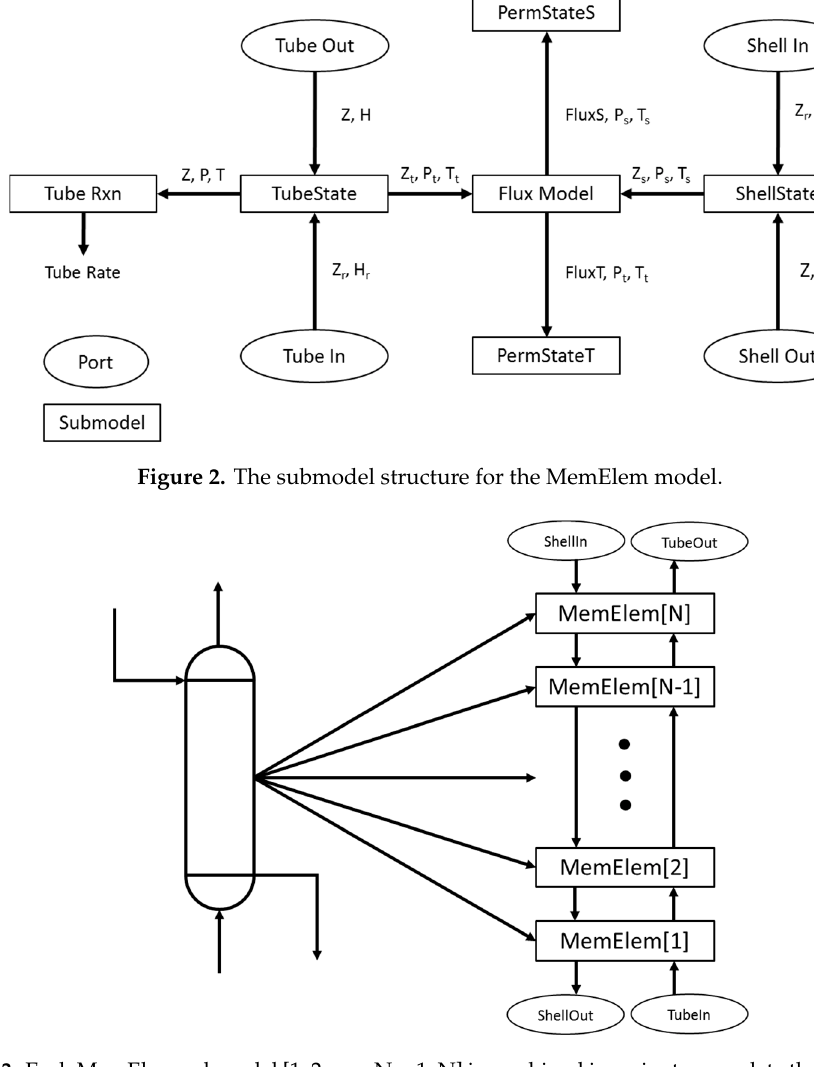
Figure 3. Each MemElem submodel [1, 2, …, N − 1, N] is combined in series to complete the calculation of the full polymer membrane reactor unit.